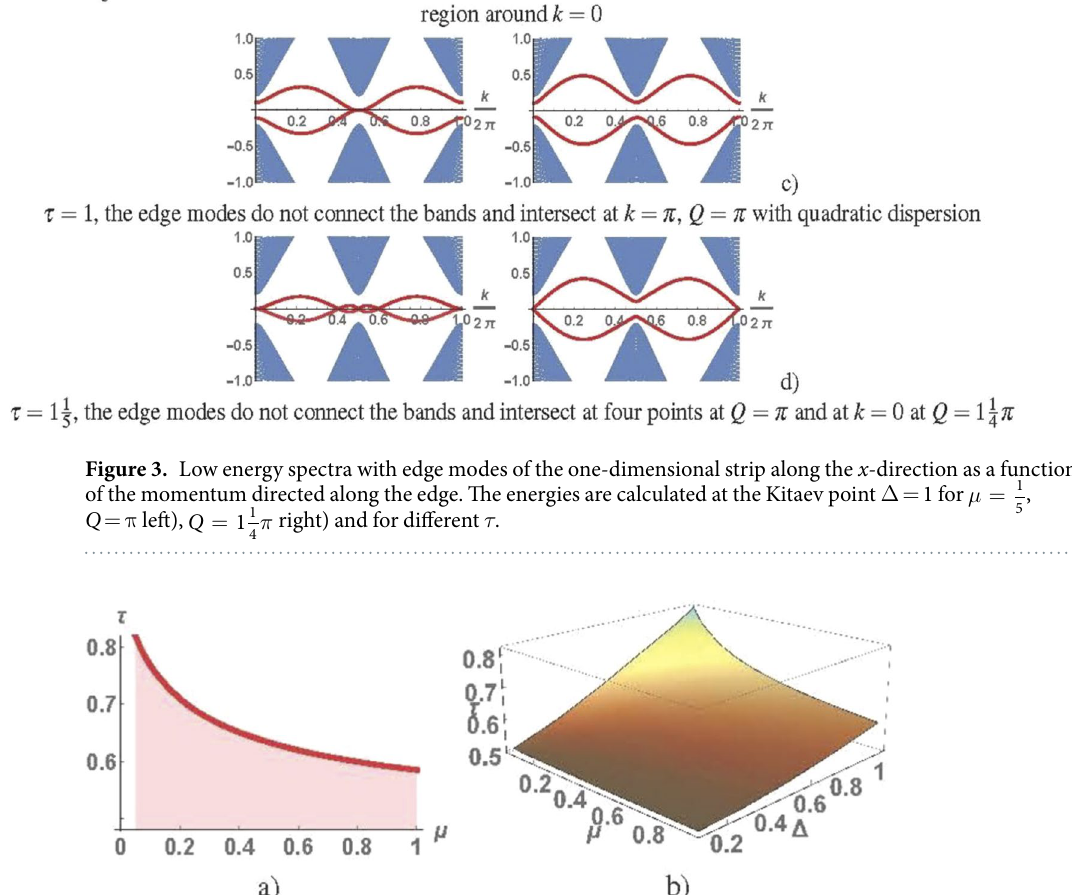
Figure 4. Numerical calculation of τ c at Q = π as a function of μ , Δ = 1 ( a ) and τ c as a function of μ and Δ ( b